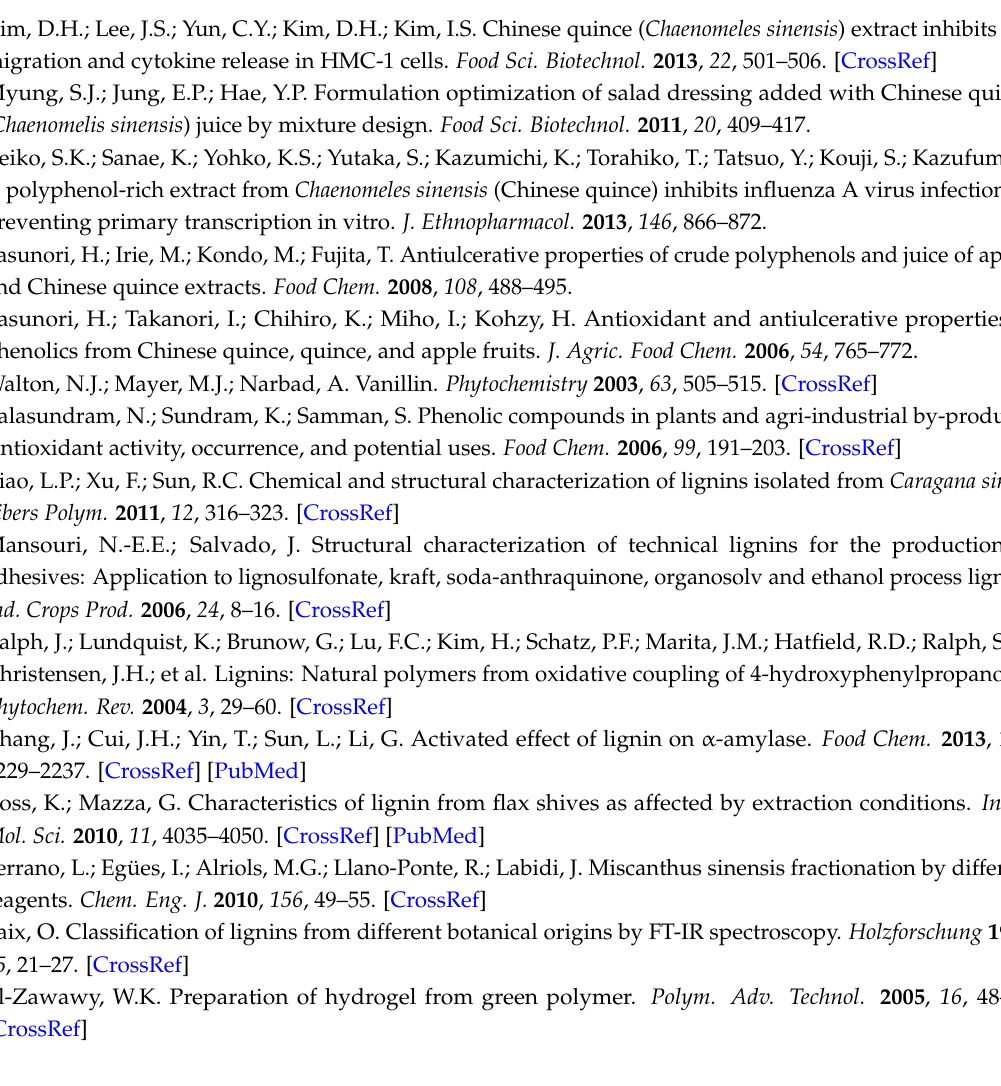
Table S1: Identity and relative molar abundances of the compounds released after Py-GC/MS of the FMWL and SMWL, Figure S1: The structure of compounds in Table S1; Figure S2: FT-IR spectra of two ball-milled lignins of Chinese quince stalk and fruit; Figure S3: UV spectra of FMWL and SMWL; Figure S4: SEM of Chinese quince stalk and fruit before and after milling; Figure S5: Thermograms of SMWL (curve a) and FMWL (curve b); Figure S6: Pyrograms of Py-GC/MS of FMWL and